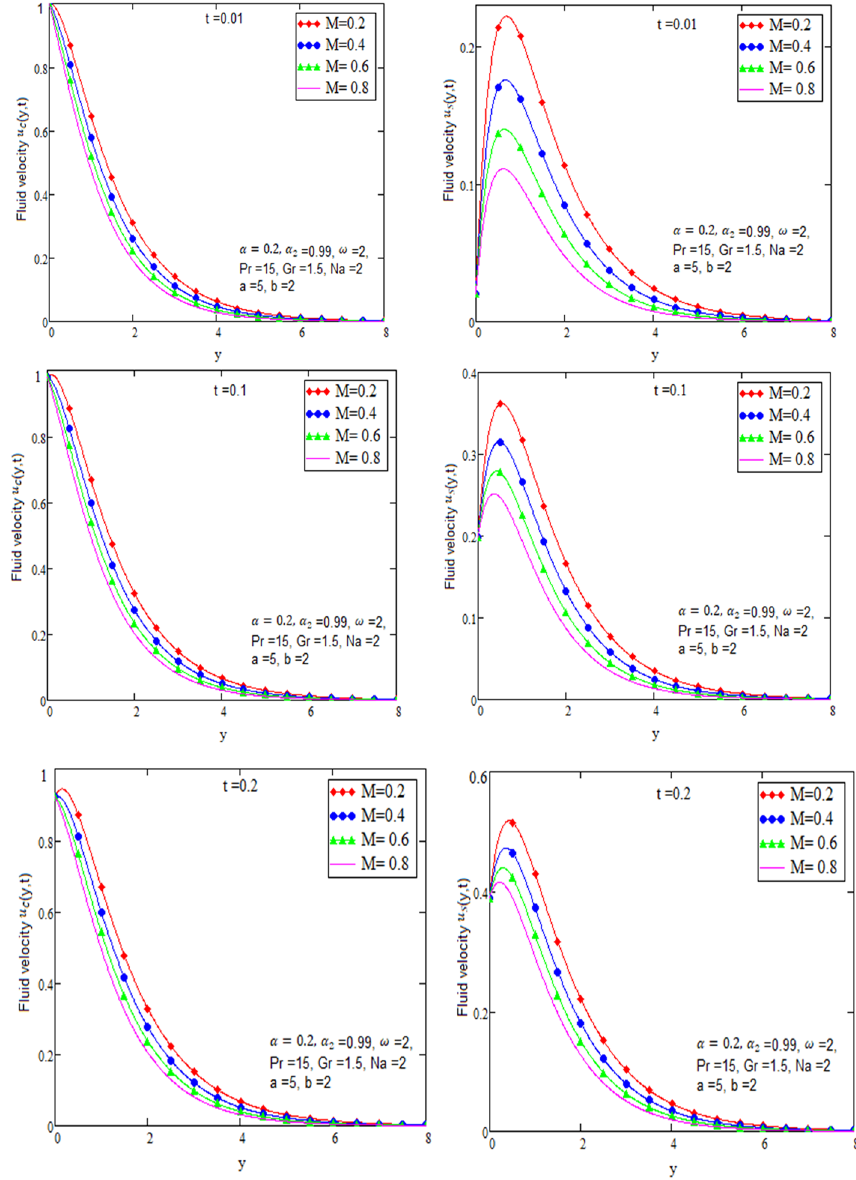
Figure 7. Graph of velocity for different value of M in case of cosine and sine